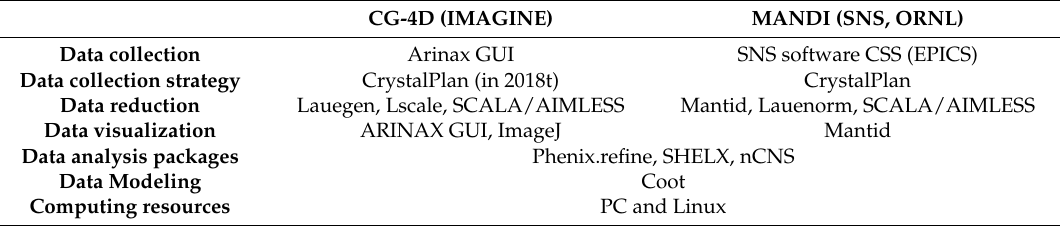
Table 3. Data reduction and refinement software used on IMAGINE,